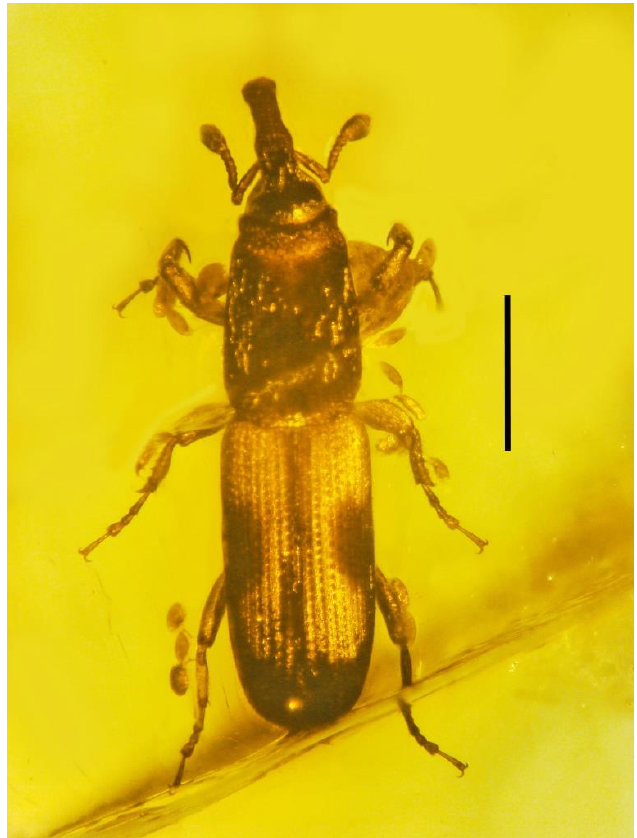
Figure 5. Mites (Arachnida: Acari) attached to a dryophthorid weevil, Bicalcasura maculata, (Coleoptera: Dryophthoridae) by hardened glue sticks in Dominican amber. Scale bar = 770 µm.